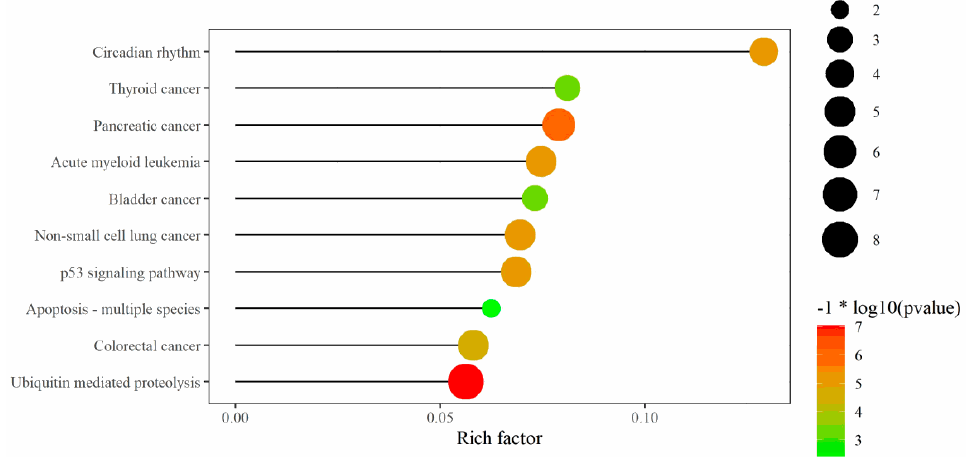
Figure 7. The KEGG analysis of the hub targets and the common targets shared between three and four miRNAs.